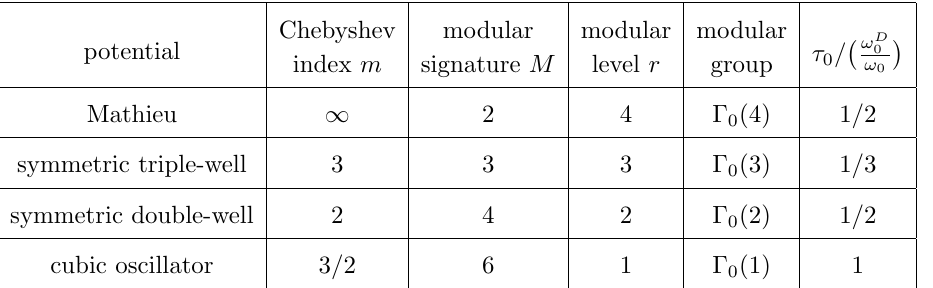
Table 2 . The modular signature M and level r , and their associated QM Chebyshev potential and modular group. This is the the special class of Chebyshev potentials (respectively, Mathieu, symmetric triple well, symmetric double well, and cubic oscillator) associated with Ramanujan’s theory of elliptic functions with respect to alternative bases, featured in sections 3.2 and 4, and for which the quantum Matone and quantum Wronskian conditions take the special all-orders form in (1.5) and